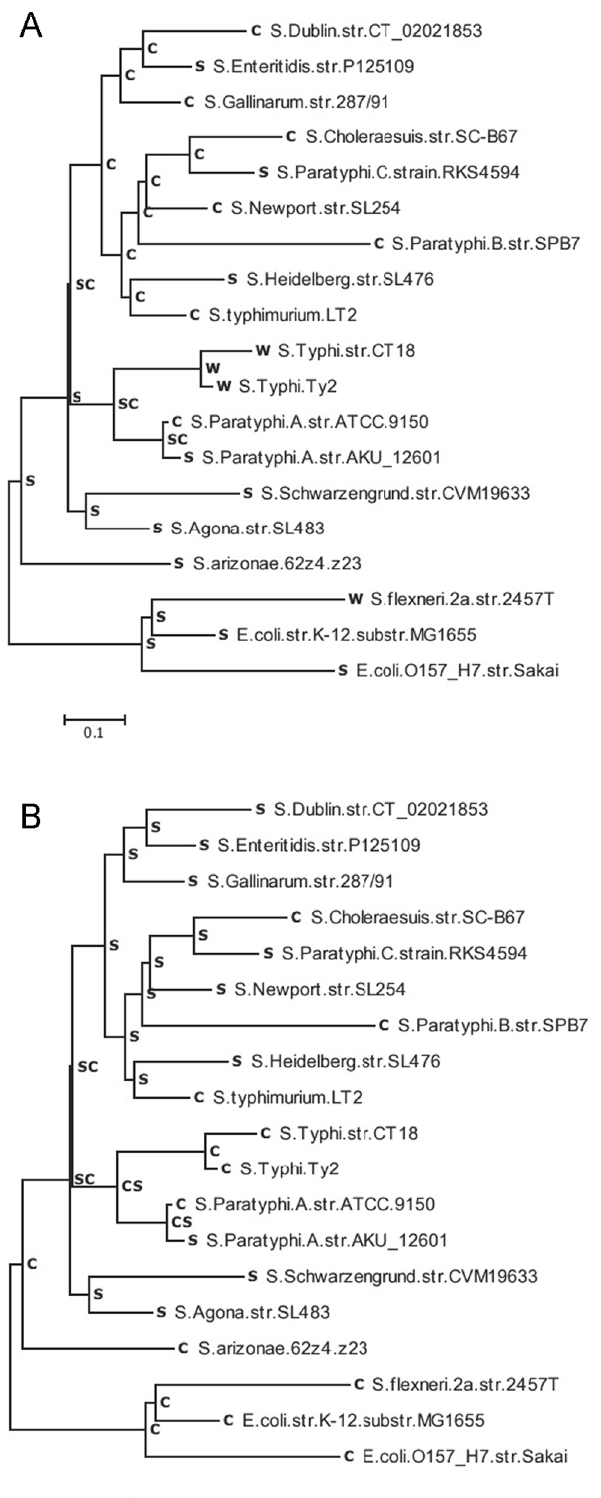
Figure 5. Phylogenetic map of the overlapping gene pairs. (A) Phylogenetic map of the overlapping gene pair ( bcsC , bcsZ ). (B) Phylogenetic map of the overlapping gene pair ( ompR , envZ ).